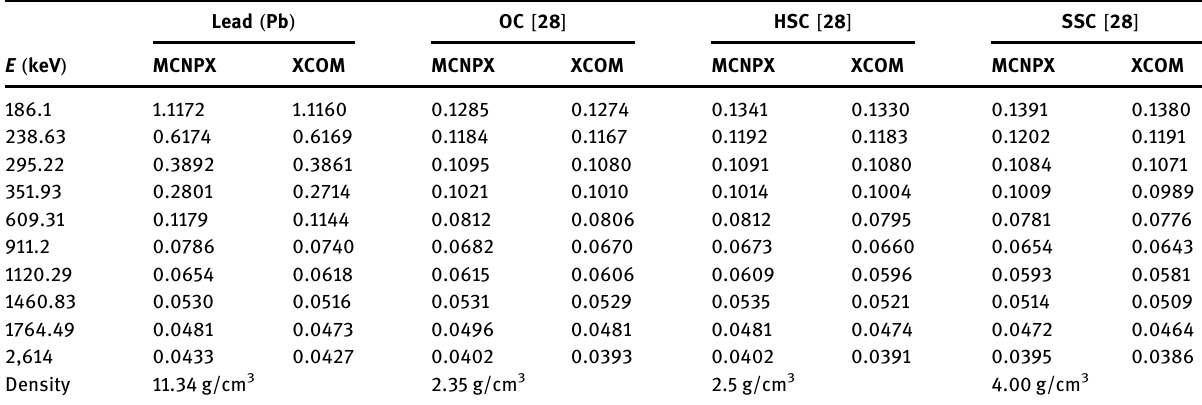
Table 2: Comparison of mass attenuation coe ffi cients for di ff erent types of materials obtained from MCNPX general - purpose Monte Carlo code and standard NIST ( XCOM )